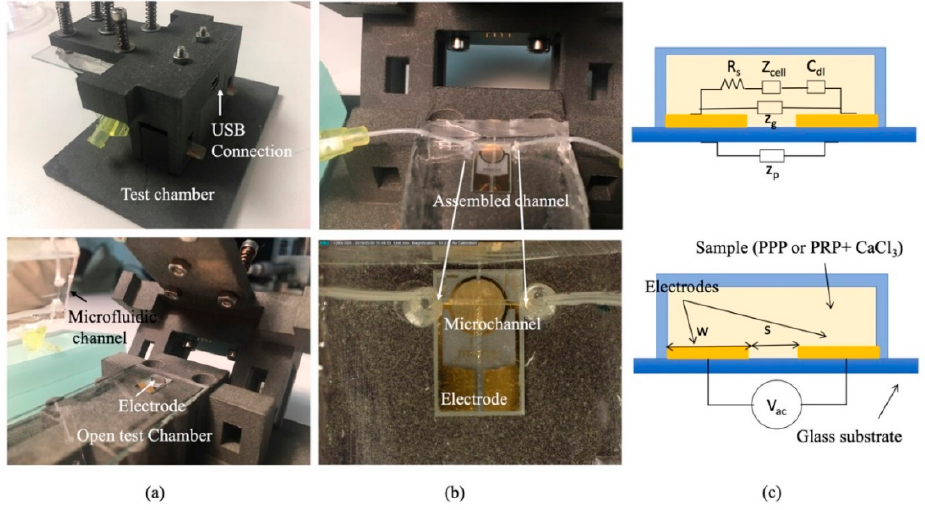
Figure 2. ( a ) Pictures of the test chamber assembled and open. ( b ) Pictures of the microfluidic channel inside the test chamber with the thrombogenic surface with embedded electrodes. ( c ) Impedance model of the electrode inside the channel.